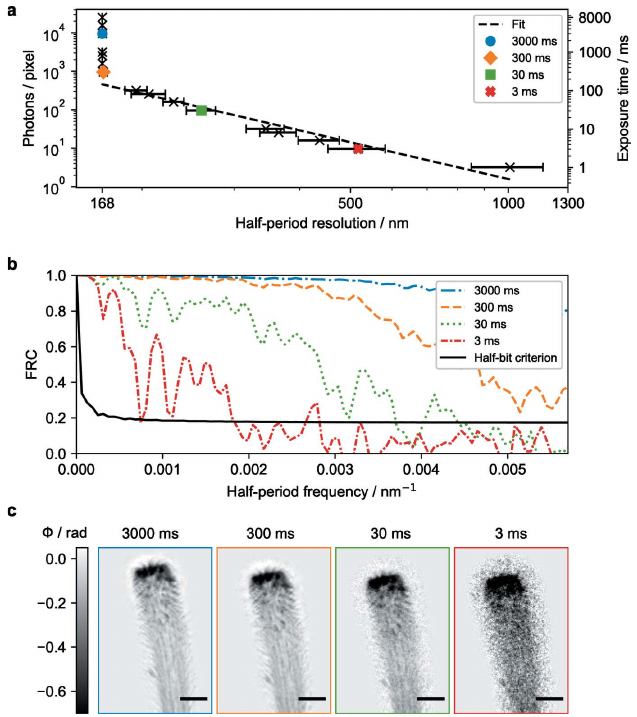
Figure 5 ( a ) Half-period resolution of holographic reconstructions (2D projec- tions) as a function of the number of photons per pixel. ( b ) Estimation of the half-period resolution via the FRC for different exposure times. ( c ) Phase reconstructions of a spider attachment hair for different exposure times ranging from 3 to 3000 ms. At 300 ms, the detector sampling limits the achievable resolution. The scale bar indicates 5 m